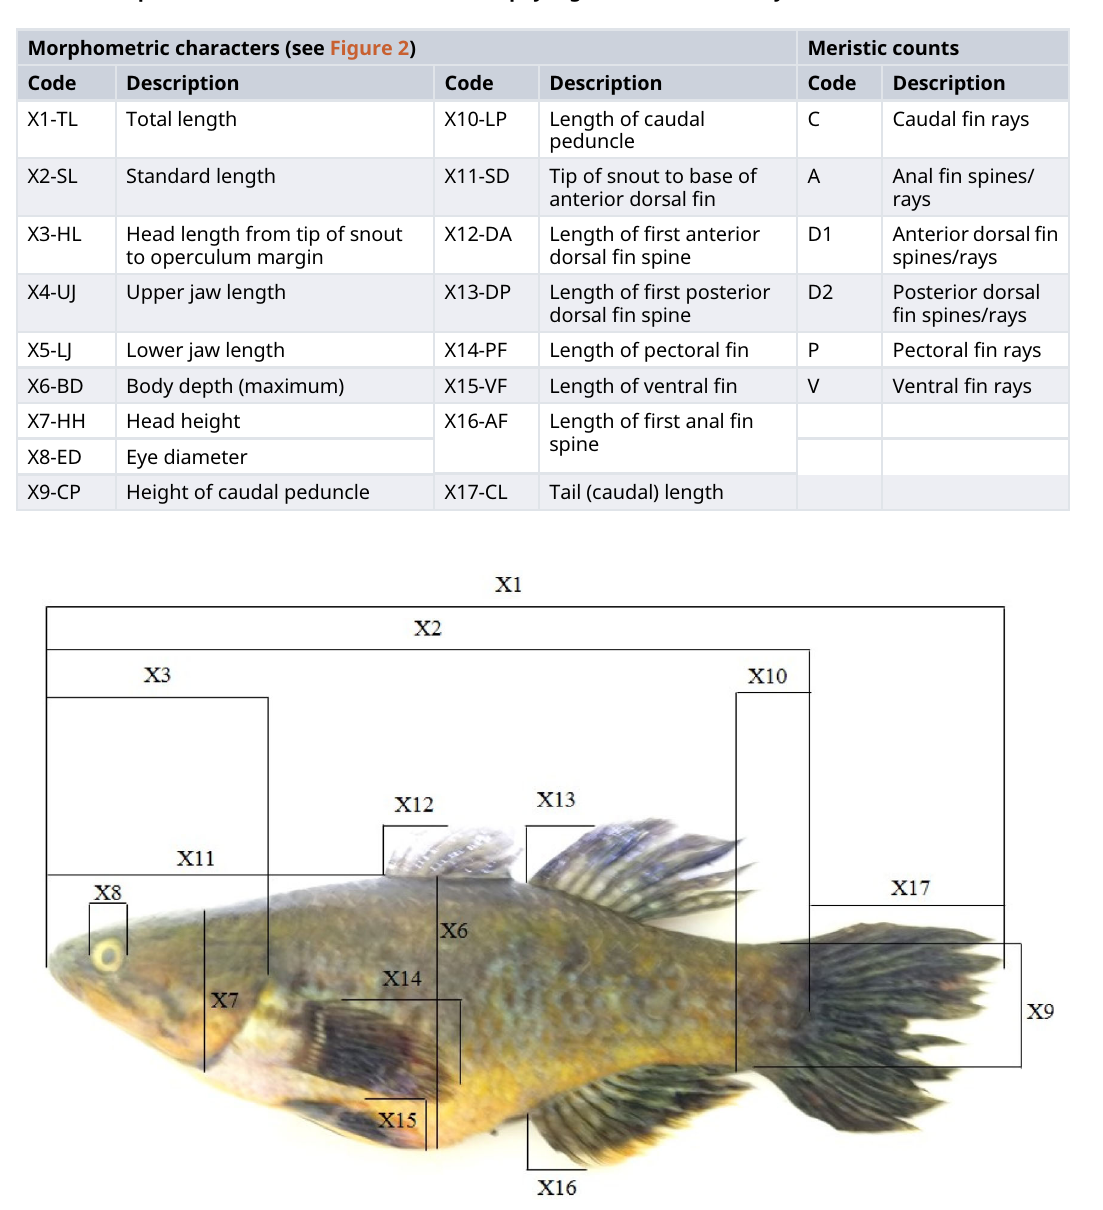
Figure 2. Morphometric characters of Bolano Sau Lake payangka measured in this